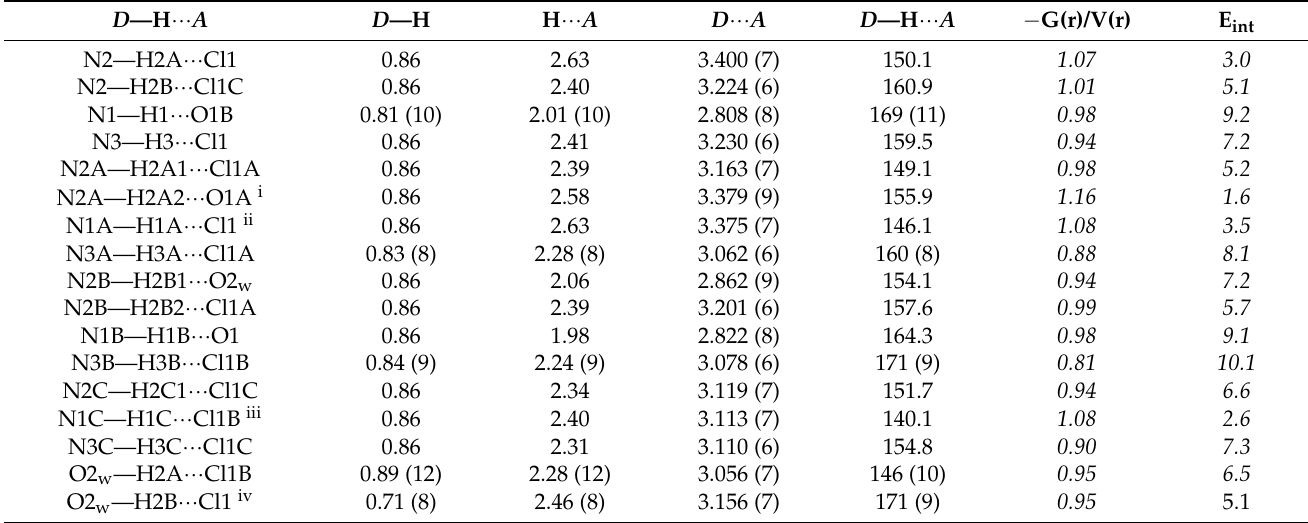
Table 1. Hydrogen-bond geometry (Å, ◦ ) and topological analysis for compound ( I ). E int is reported in kcal/mol. For additional details concerning QTAIMS results see Table S1 in the Supporting Information.